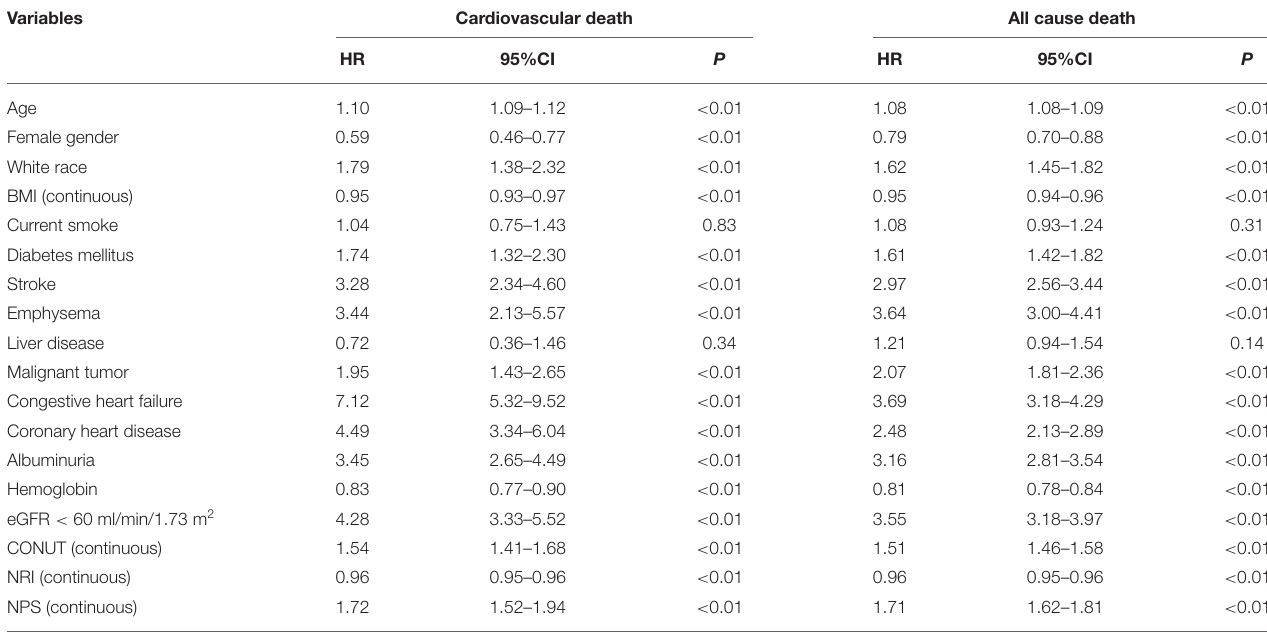
TABLE 4 | Univariate Cox regression for long-term mortality. Variables